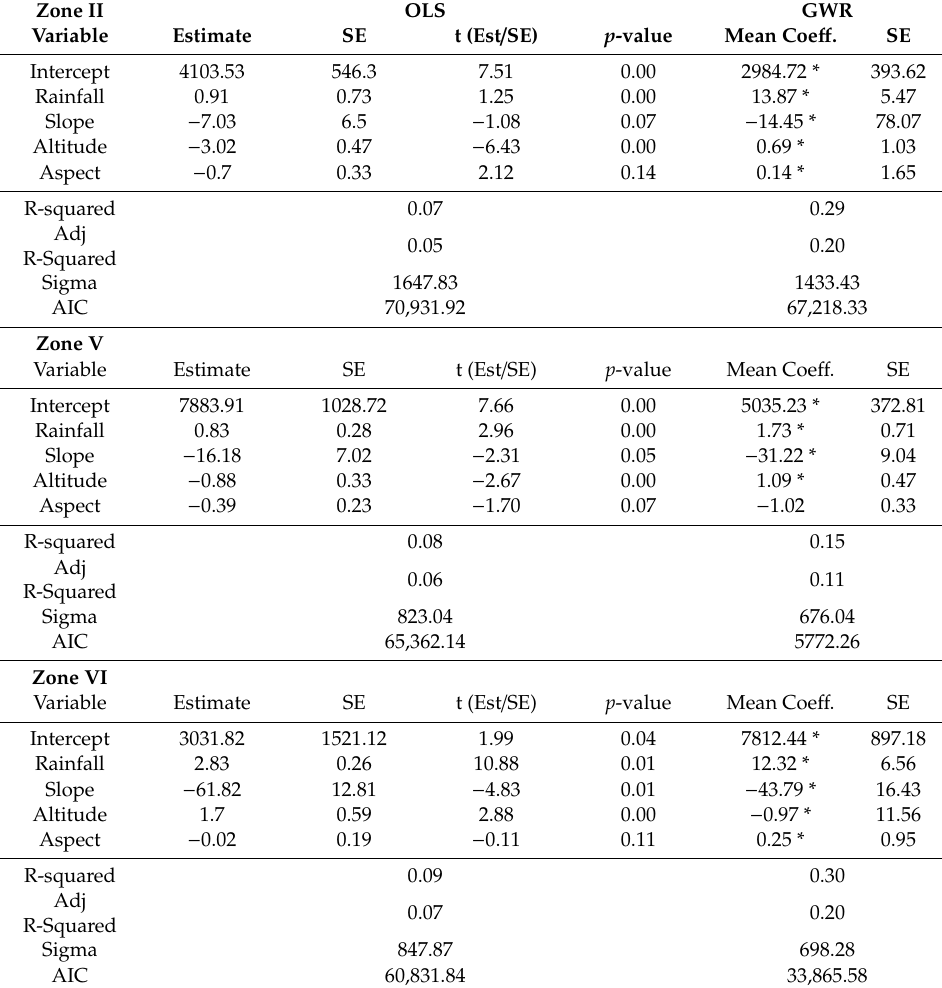
Table 11. Comparison between OLS and GWR for the four studied factors (aspect, altitude, slope, and rainfall) at the three agrarian zones: zone II in the northern Montaña region, zone V in the Media region, and zone VI in the Ribera Alta Southern region. GWR: geographically weighted regression and OLS: ordinary least squares. SE refers to standard error.